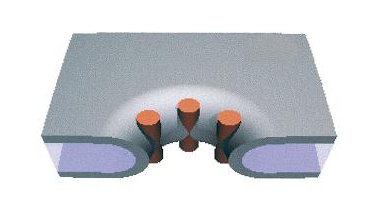
Figure 1: toroidal pore induced by LCAMP action, where the pore is lined with both lipid and peptide molecules [3].